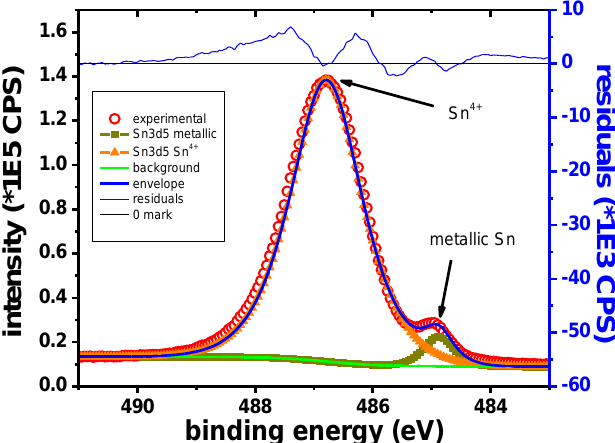
Figure 12. O1s narrow scan, Zn sample.